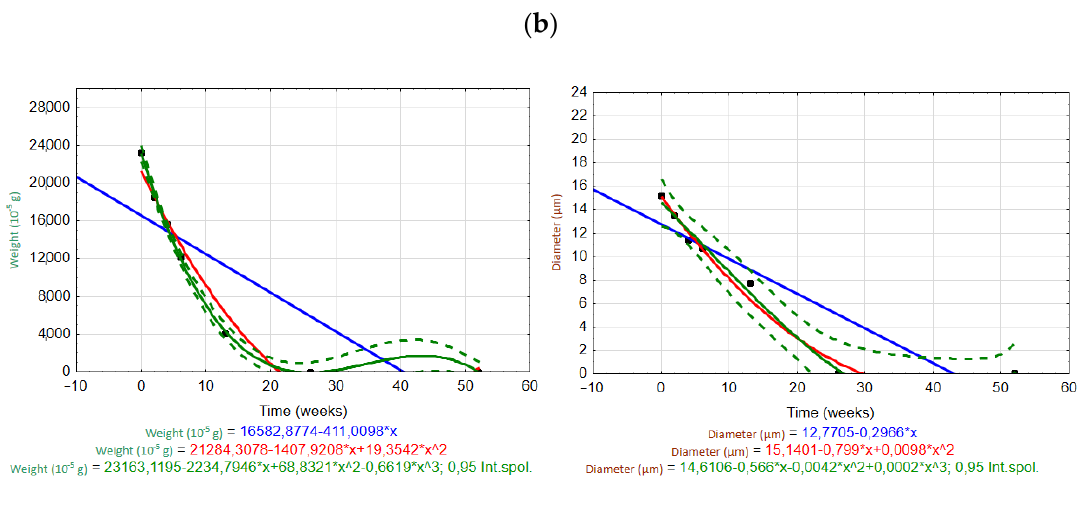
Figure 9. Scatter plots of the temporal trends for the EGF weight (left) and fiber diameter (right) in different solutions: ( a ) H 2 O, ( b ) Ca(OH) 2 , and ( c ) K 2 SiO 3 . (Int.spol. mean confidence interval).